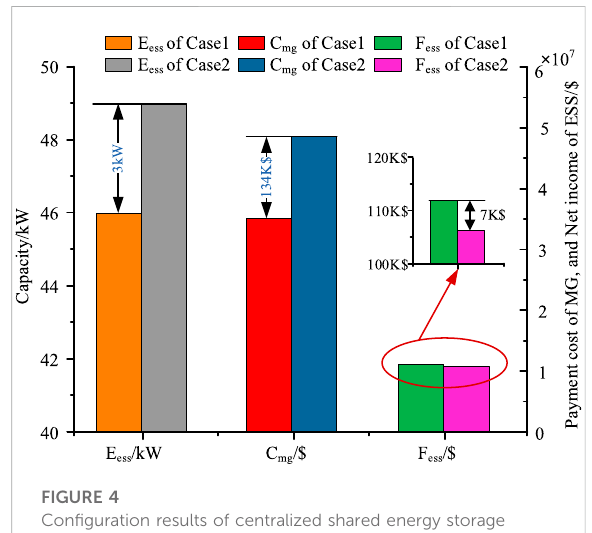
FIGURE 4 Con fi guration results of centralized shared energy storage under different conditions.